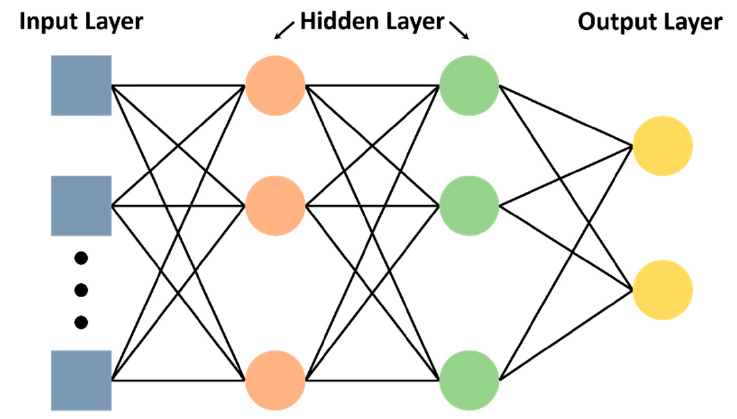
Figure 2. MLP architecture diagram.